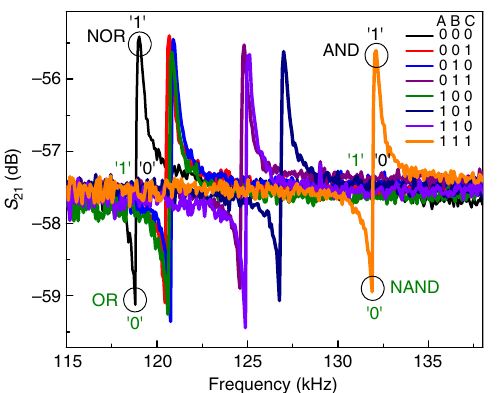
Figure 8 | Realization of 3-bit logic gates. Frequency responses of the resonator for three different input logic conditions. NOR gate is realized by choosing the frequency of operation at 119.022kHz, where (0,0,0) logic input condition has high S 21 transmission signal and all the others have low S 21 transmission signal. By choosing the corresponding anti resonance dip frequency, 3-bit OR gate can be realized. A 3-bit AND gate is realized by choosing the frequency of operation at 132.105kHz, where (1,1,1) logic input condition has high S 21 transmission signal and all others have low S 21 transmission signal. By choosing the corresponding anti resonance dip frequency, a 3-bit NAND gate can be realized.